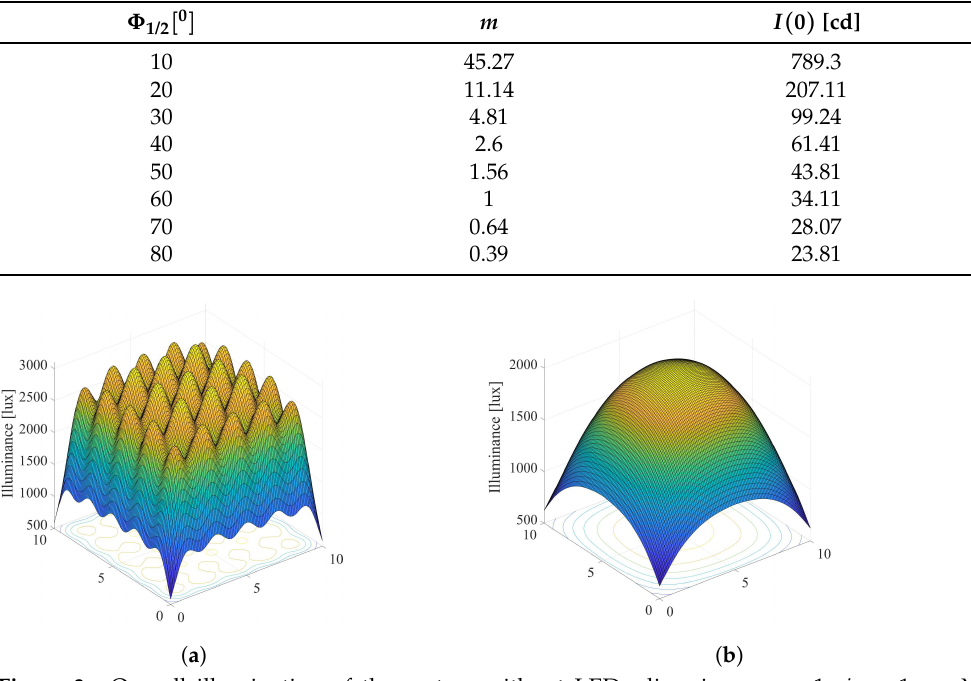
Figure 3. Overall illumination of the system without LEDs dimming, s i = 1, i = 1, . . . , N . ( a ) Φ 1/2 = 20 0 . ( b ) Φ 1/2 = 60 0 .